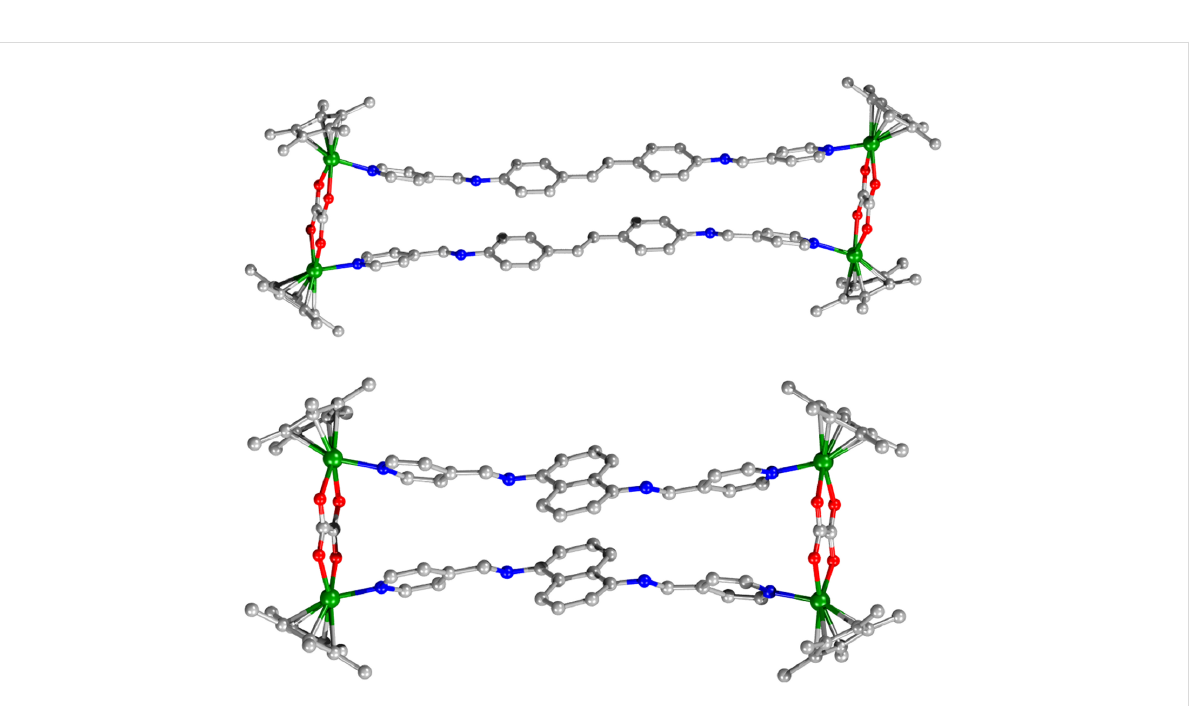
Figure 4: Optimized structures of the charged metallarectangles 3a (top) and 3b (bottom), optimized with the molecular mechanics force field. The graphics were produced using the Diamond software package. Colors: C, gray; O, red; N, blue; rhodium, green (hydrogen atoms have been removed for